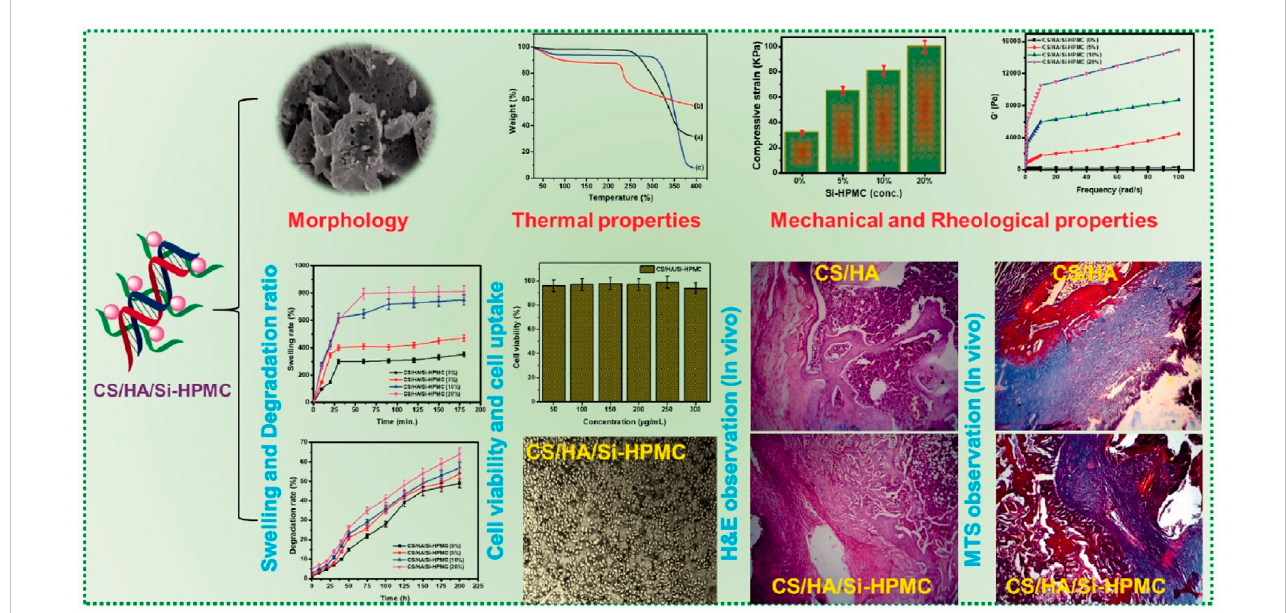
FIGURE 1 Schematic representation of the synthesis process of Si-HPMC incorporated CS/HA injectable hydrogel. The regeneration rate of the CS/HA/Si-HPMC (3%) was almost 79.5% at 21days for long retention periods, demonstrating relatively good in vivo bone regeneration (Hu et al., 2021) (Open